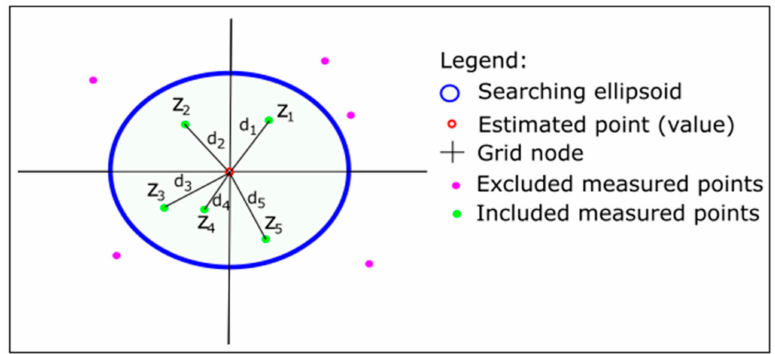
Figure 5. Searching ellipsoid, measured and estimated points used for the Inverse Distance Weighting calculation.